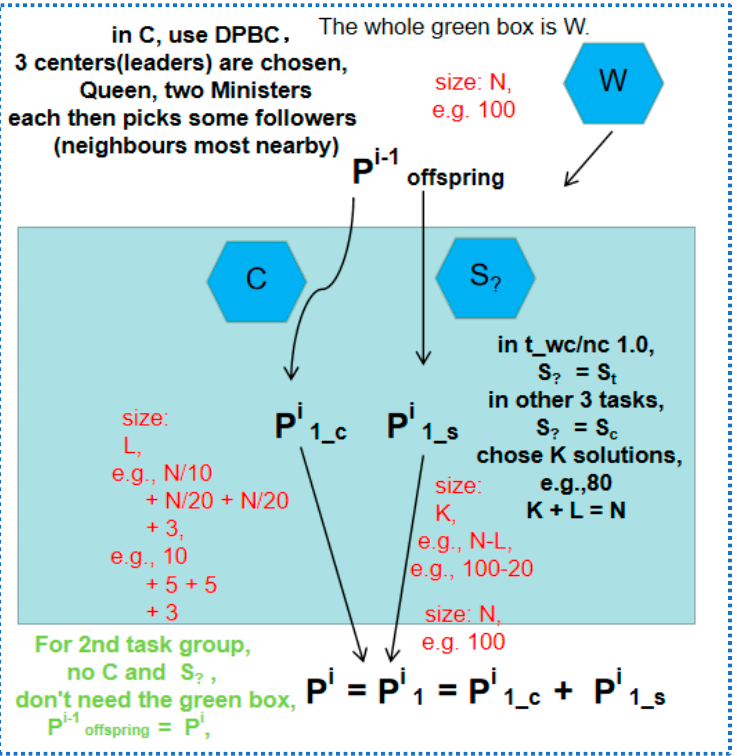
Figure 3. We can see the details of the clustering operator W [5] for investigation of positional building blocks. Here, we choose parents P i as an example. Moreover, the clustering algorithm DPBC is in operator C. DPBC is quite complex, which will be analyzed further in Figure 4.